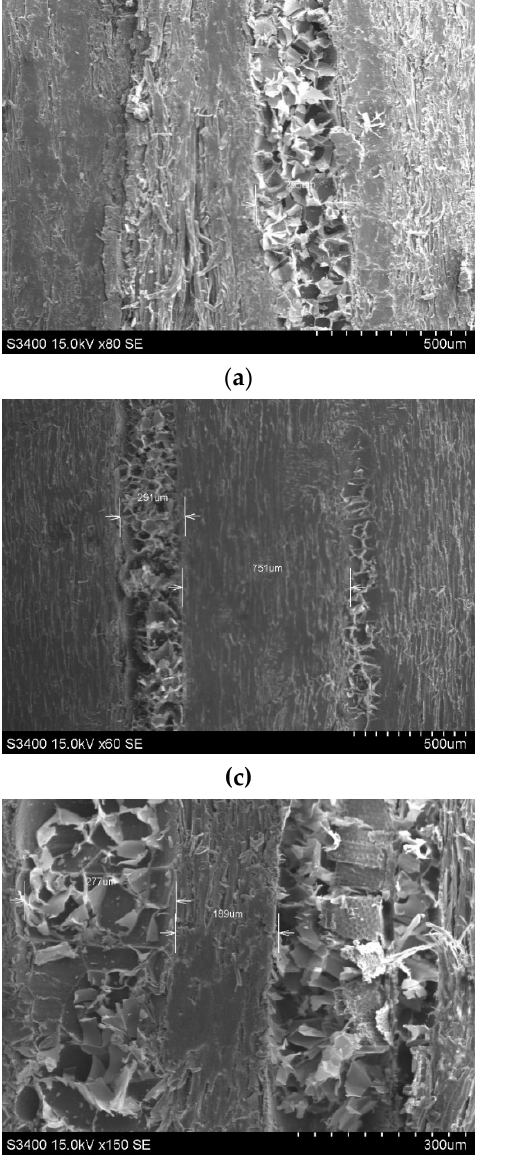
Figure 16. SEM view on cross-section of wood: ( a ) control sample magnification ×60 SE; ( b ) control sample magnification ×400 SE; ( c ) sample T1 (first treatment) magnification ×70 SE; ( d ) sample T1 (first treatment) magnification ×160 SE; ( e ) sample T2 (second treatment) magnification ×65 SE; ( f ) sample T2 (second treatment) magnification ×180 SE.